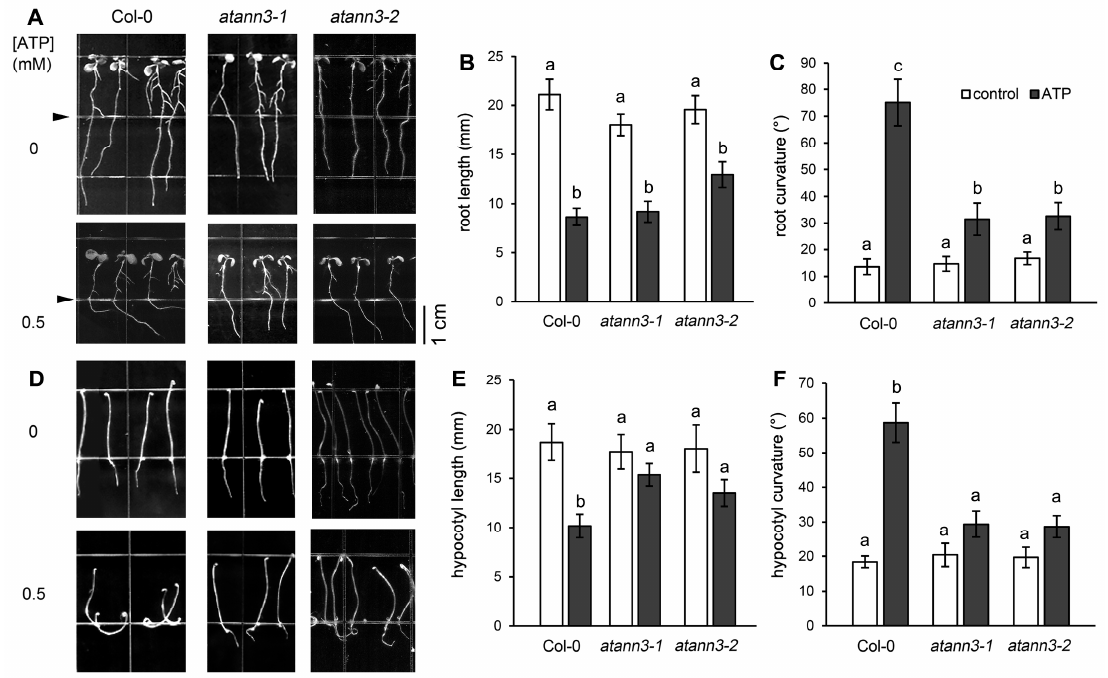
Figure 1. AtANN3 is involved in the eATP-regulated seedling growth of Arabidopsis thaliana . ( A – C ) The 4-day-old seedlings were transplanted onto the combined medium and cultured under light conditions for 5 more days. The concentration of ATP in the lower compartment was 0.5 mM. The triangles mark the border between the two growth media. ( A ) The growing seedlings and ( B , C ) the root length and root curvature of seedlings, respectively. ( D – F ) Seeds were sown and cultured on the medium containing 0.5 mM ATP in the dark for 5 days. ( D ) The growing etiolated seedlings and